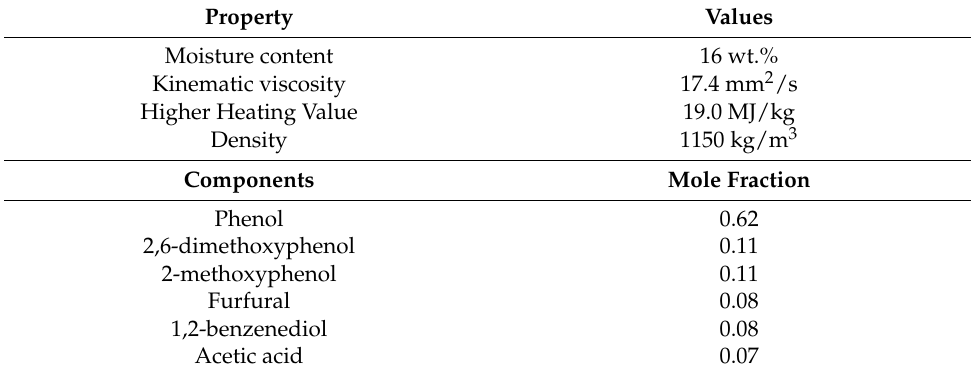
Table A2. Pyrolysis bio-oil